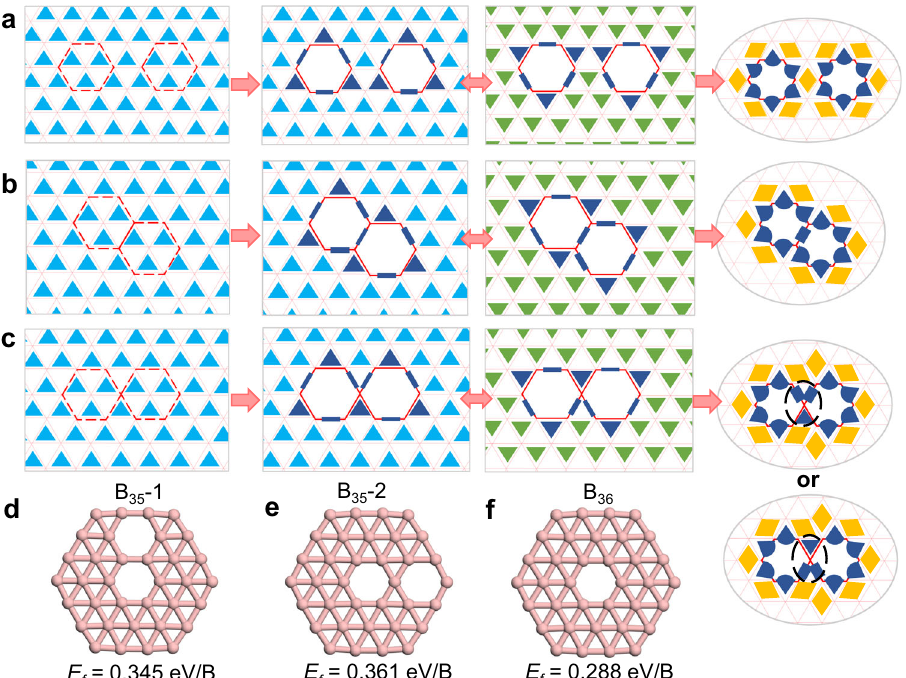
Fig. 4 | σ bonding analysis of three different double-hole structures in a 2D boron sheet. a - c σ bonding con fi gurations of ( a ) two separated hexagonal holes, ( b ) two hexagonal holes with the shoulder-by-shoulder structure, and ( c ) two